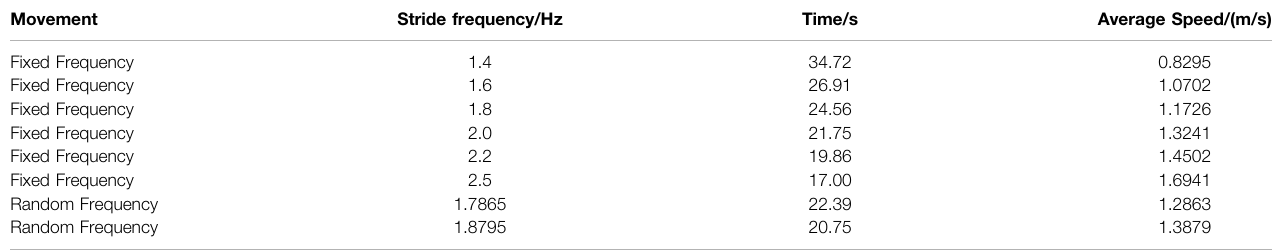
TABLE 4 | Experimental data of tester 1 walking at different step frequencies. Movement